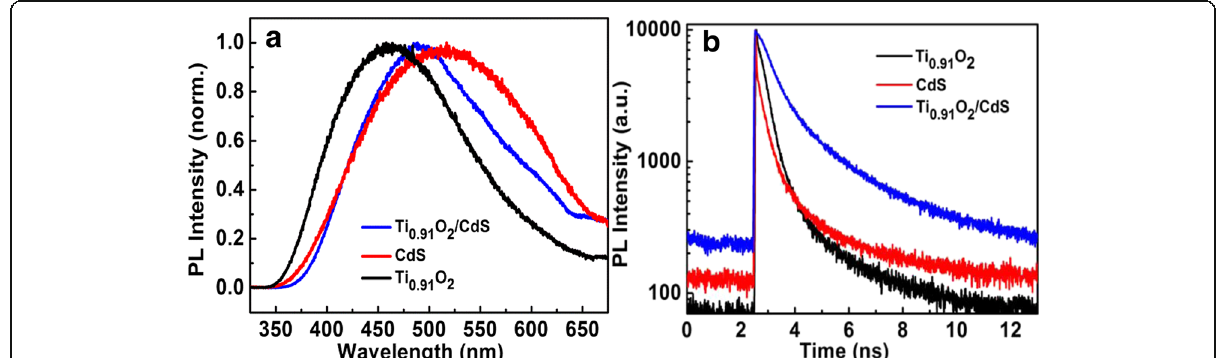
Fig. 2 a PL spectra of the Ti 0.91 O 2 (black), CdS(red), and Ti 0.91 O 2 /CdS (blue) samples excited at 266 nm. b PL decay curves of the Ti 0.91 O 2 (black), CdS(red), and Ti 0.91 O 2 /CdS (blue) samples with the 266 nm